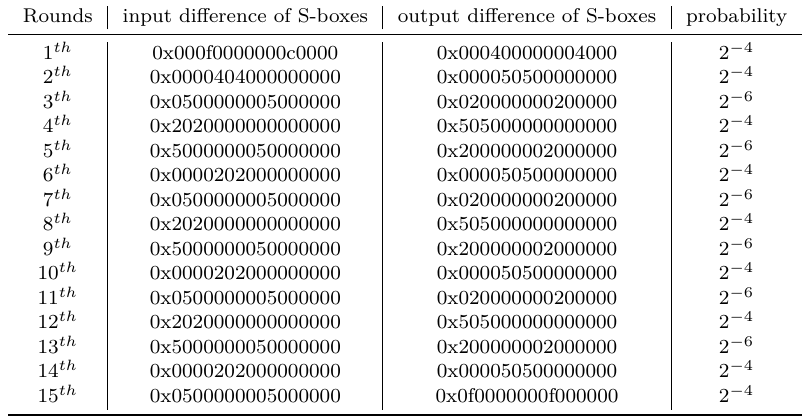
Table 10: The best differential characteristic with probability 2 − 72 for 15-round GIFT-64